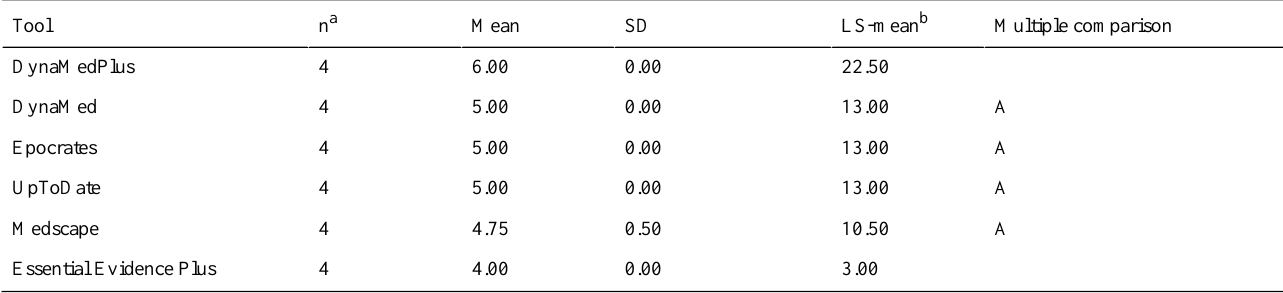
Table 2. Ease of use among six point-of-care tools.